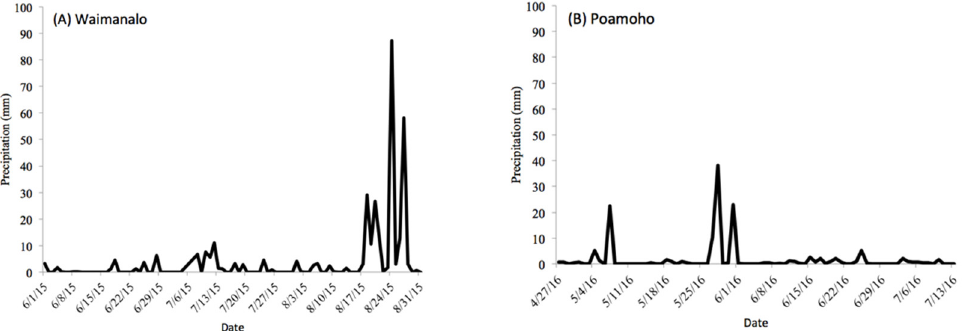
Figure 1. Daily mean precipitation over the study period at ( A ) Waimānalo and ( B ) Poamoho Research Stations in O’ahu, Hawai’i.